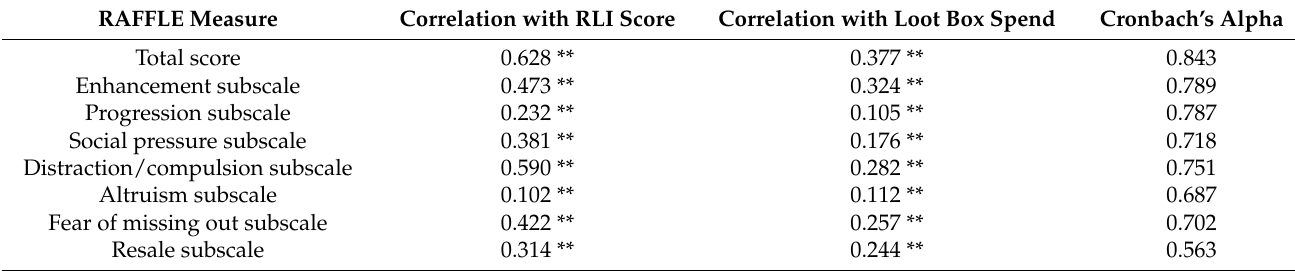
Table 6. Construct and criterion-related validity and reliability metrics for RAFFLE overall and subscale